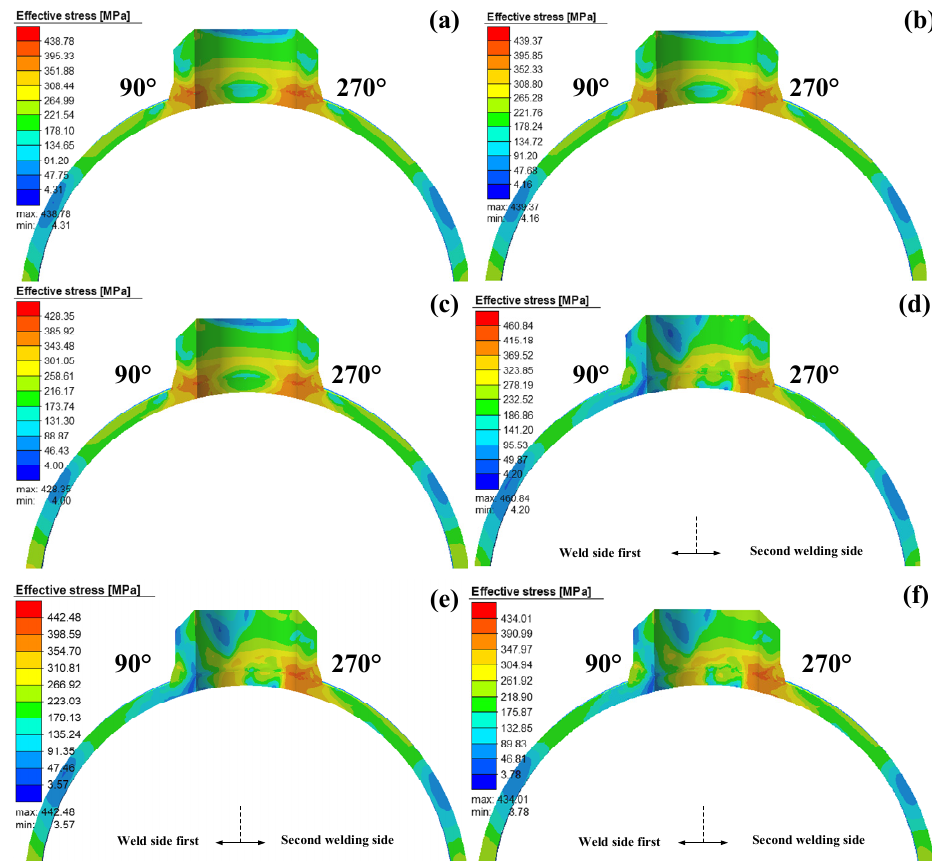
Figure 13. Contours of Von Mises stress for the 90°–270° cross-section: ( a ) Case1, ( b ) Case2, ( c ) Case3, ( d ) Case4, ( e ) Case5, ( f ) Case6.